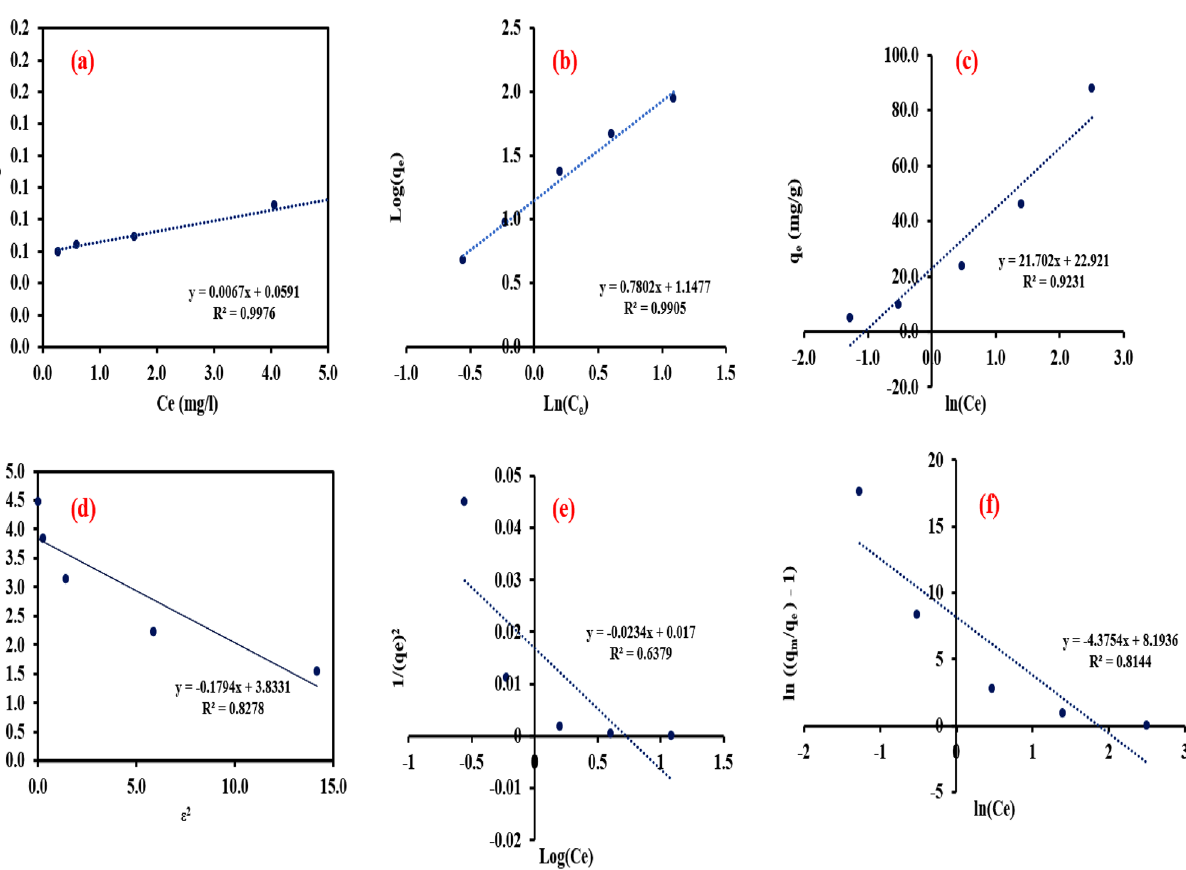
Figure 10. Adsorption isotherms ( a ) Langmuir model, ( b ) Freundlich model, ( c ) Temkin model, ( d ) Dubinin- Radushkevish model, ( e ) Harkins–Jura model and ( f ) Generalized isotherm Adsorption thermodynamics. The linear plot of ln(q o , ΔS o and e /q c ) versus 1/T is shown in Fig. 11. ΔH ΔG o values were estimated and listed in Table 3. The negative value of ΔG o and negative value of ΔH o suggested the spontaneous and exothermic nature of Cr(VI) adsorption on the NZVI-Si surface. Moreover, the positive value of ΔS o indicated that the randomness at the sorbent/solution interface was high. The increase of ΔG o with raising the temperature reflected the increase of spontaneity of the adsorption process with temperature.